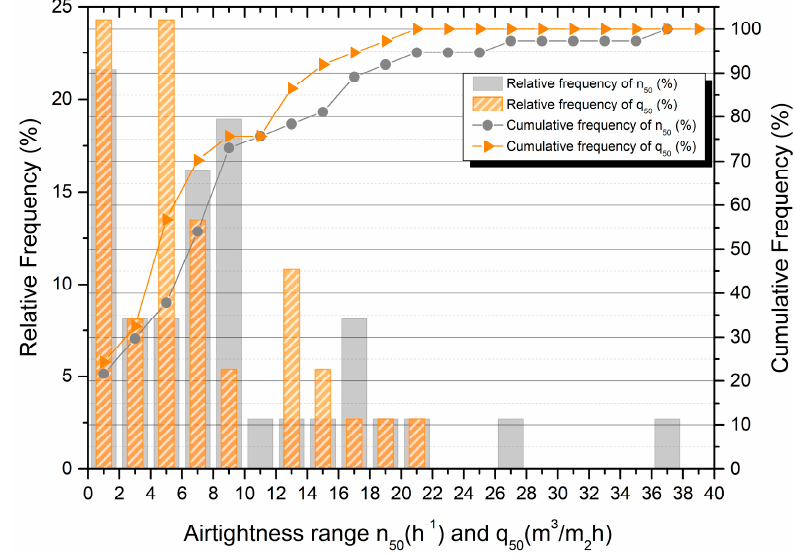
Figure 6. Statistical analysis of the relative and cumulative frequency of air permeability and air change rate at 50 Pa.